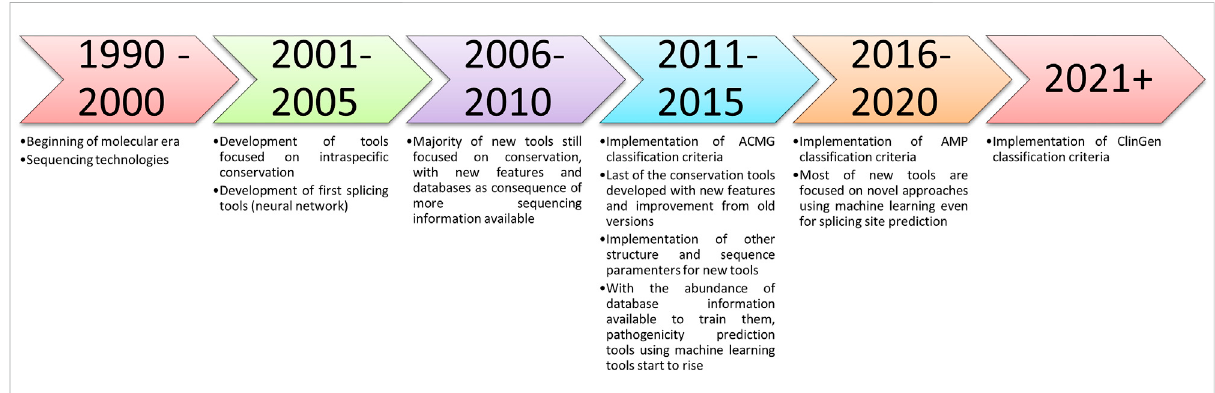
FIGURE 2 Timeline of the described in silico tools methods and the criteria implemented suggesting their